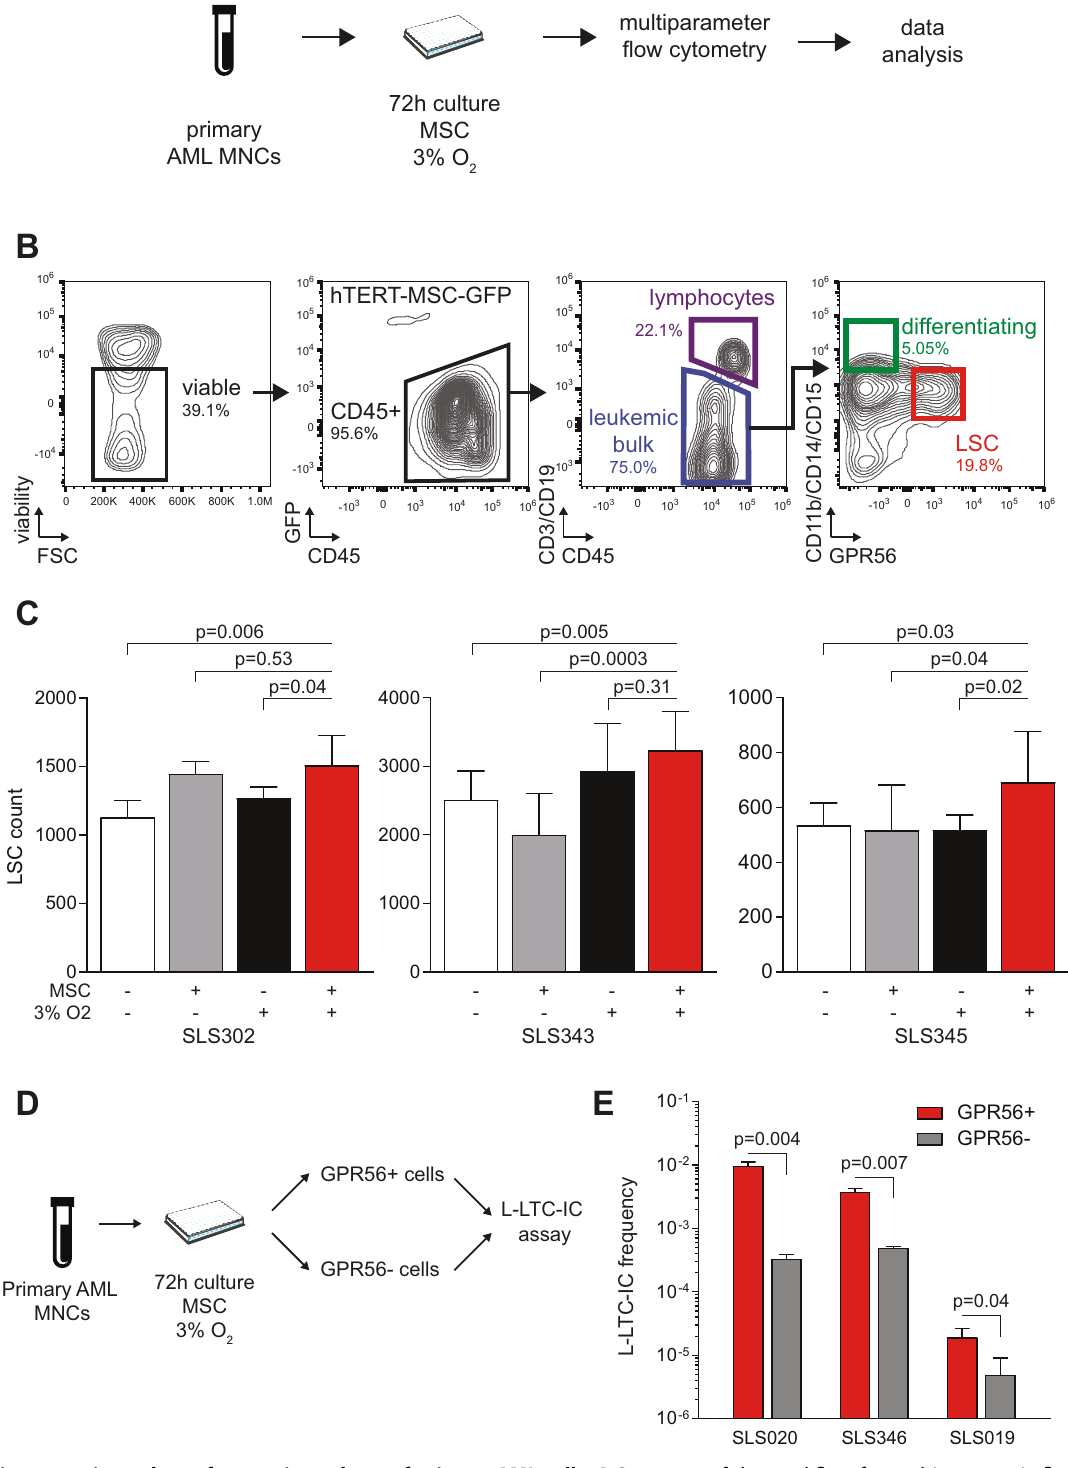
Fig. 1 Multiparametric readout after ex vivo culture of primary AML cells. A Summary of the work fl ow for multiparametric fl ow cytometry following short-term ex vivo co-culture of primary AML MNCs with MSCs in 3% O 2 . B Gating strategy. C Number of GPR56 + /Diff − LSCs after 72-hour culture with or without MSCs and with 20% (standard) or 3% (hypoxia) O 2 in three samples; 6 – 10 technical replicates per condition. Mean ± SD. T tests with Welch ’ s correction. D , E Experiment design ( D ) and L-LTC-IC output ( E ) expressed as the ratio of colonies after 5-week culture per seeded GPR56 + or GPR56- cells sorted after a 72-hour culture with MSCs and 3% O 2 in three different AML samples. Technical triplicates. Mean ± SD. Two-sided T tests with Welch ’ s correction. Clinical, phenotypic, and genetic annotations of primary AML samples are available in Supplementary Table